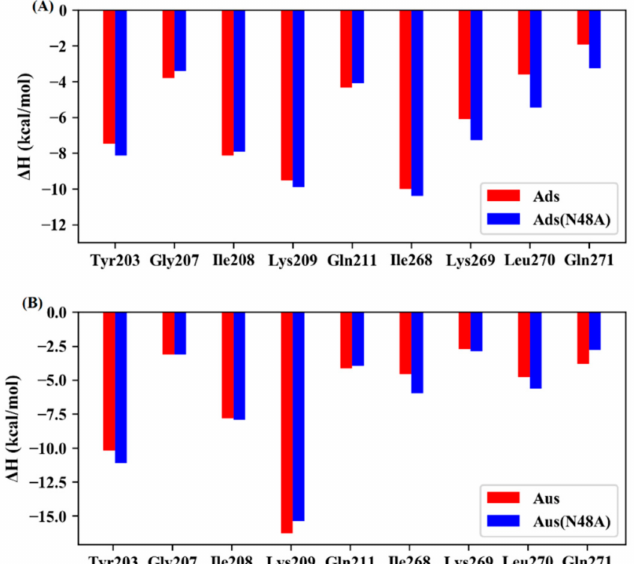
Figure 6. Key residues in the wild type and mutated systems. ( A ) Ads and Ads (N48A). ( B ) Aus and Aus